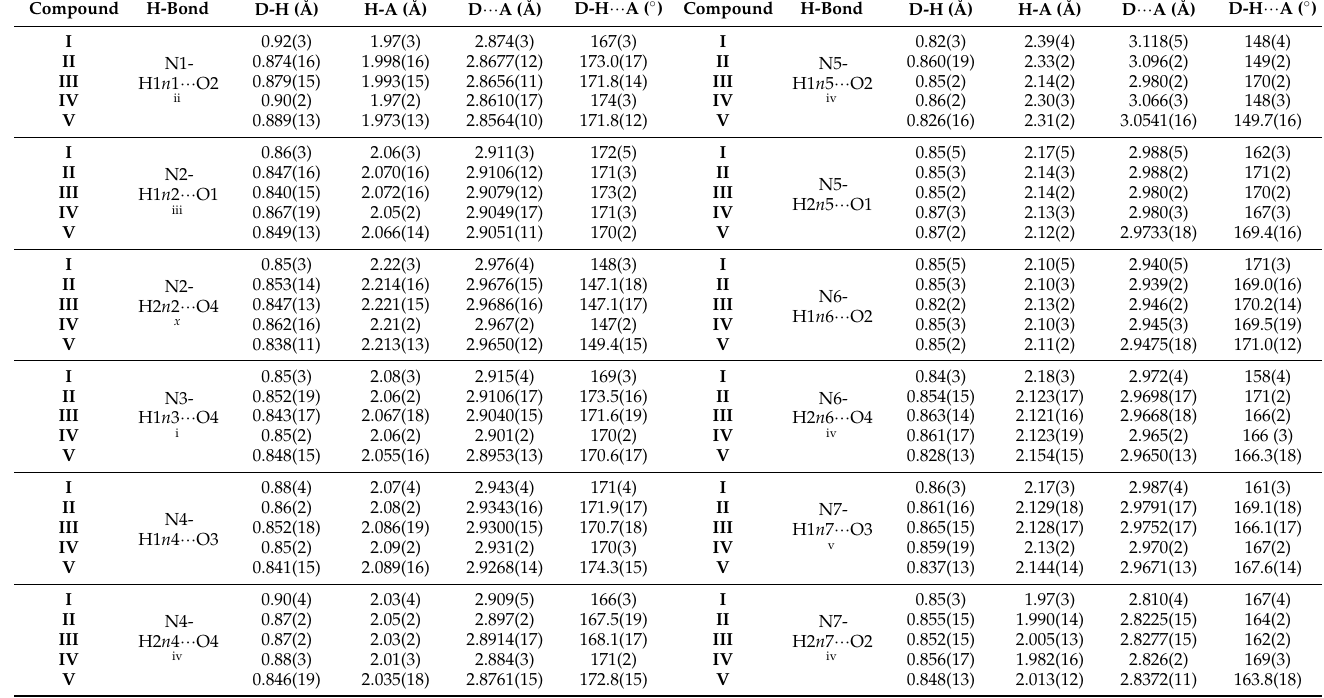
Table 3. Hydrogen-bond interactions in the title structure determinations for compounds ( I )–( V